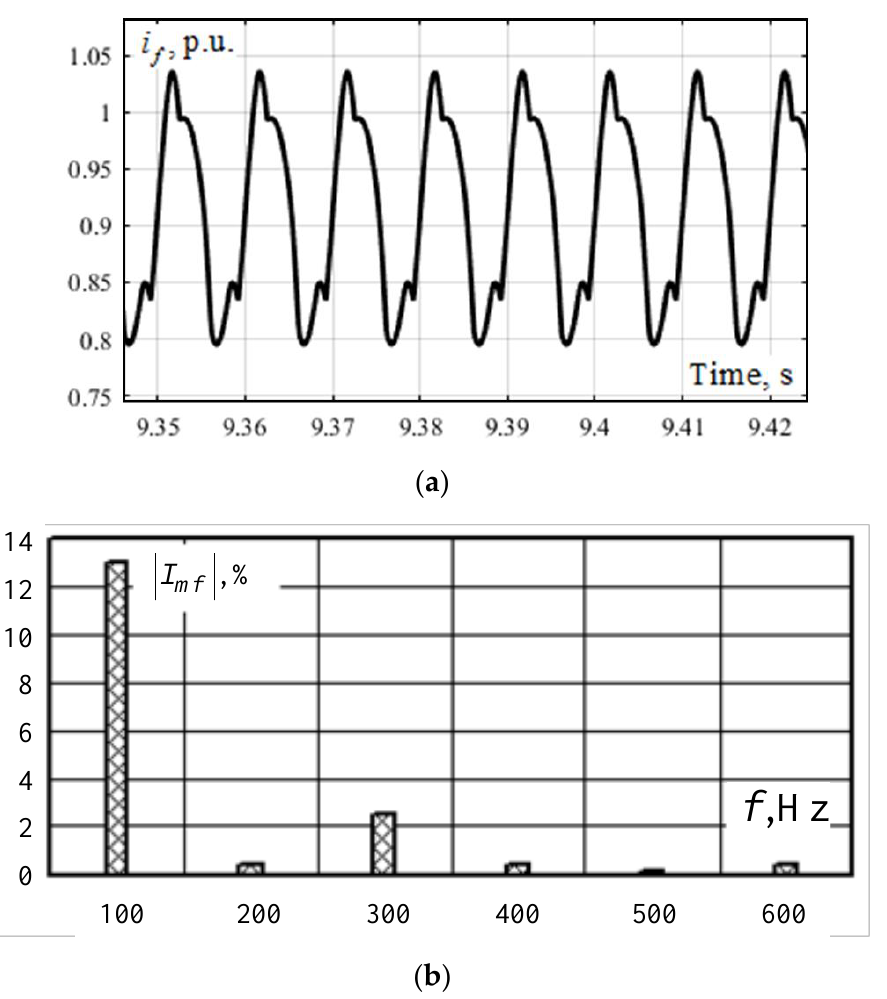
Figure 21. Waveform of the generator excitation current ( a ) and its harmonic content ( b ) given k Ua = 10.32% and k 2 U = 5.83